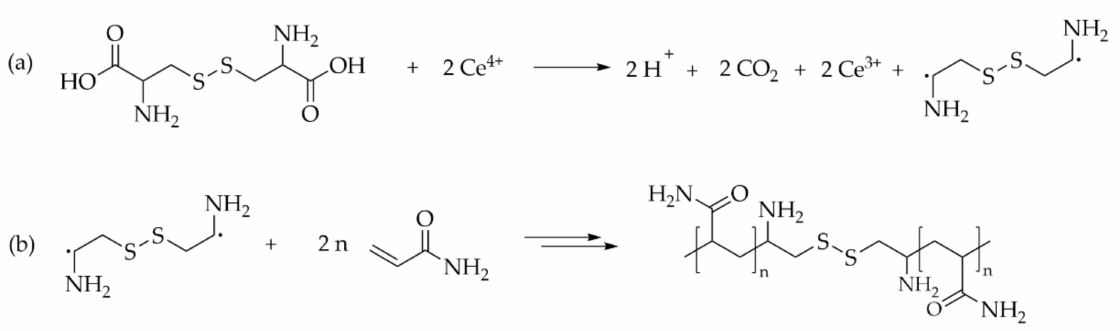
Figure 5. Mechanism of polymerization of acrylamide using Ce 4+ /Cystein redox system. ( a ) Radical generation and chain initiation; ( b ) Polymerization with